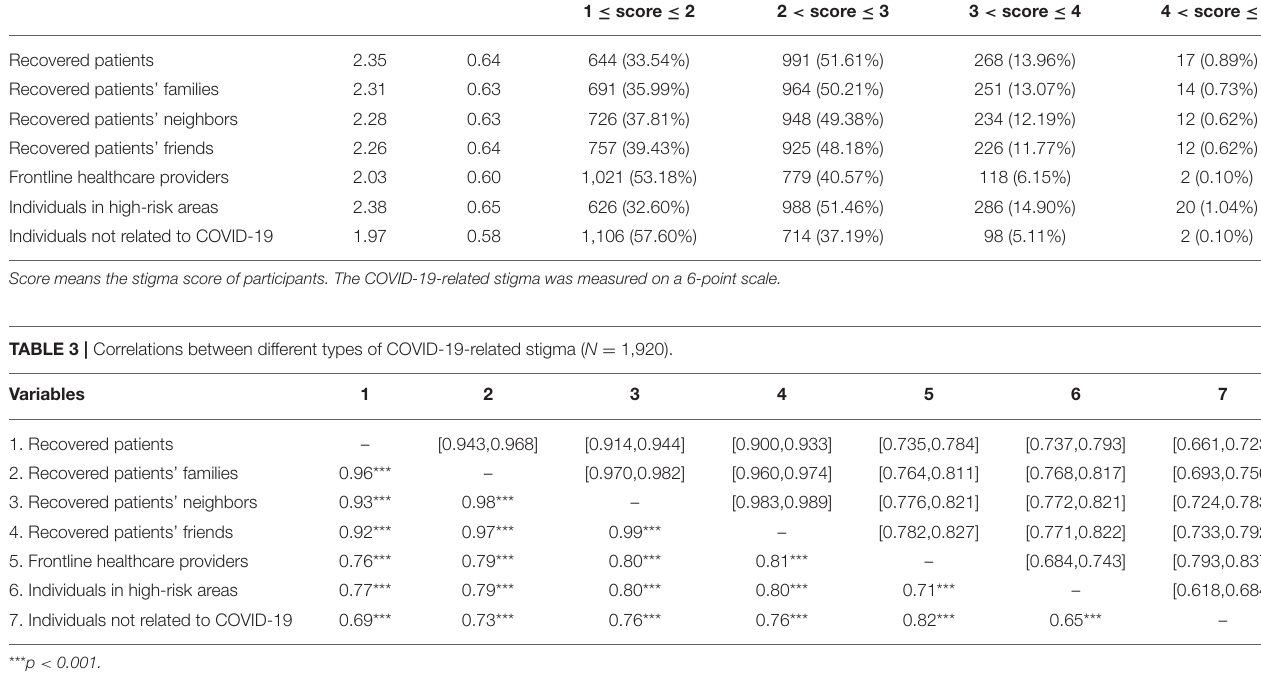
TABLE 2 | Descriptive results of the coronavirus disease 2019 (COVID-19)-related stigma scores ( N = 1,920). Variables